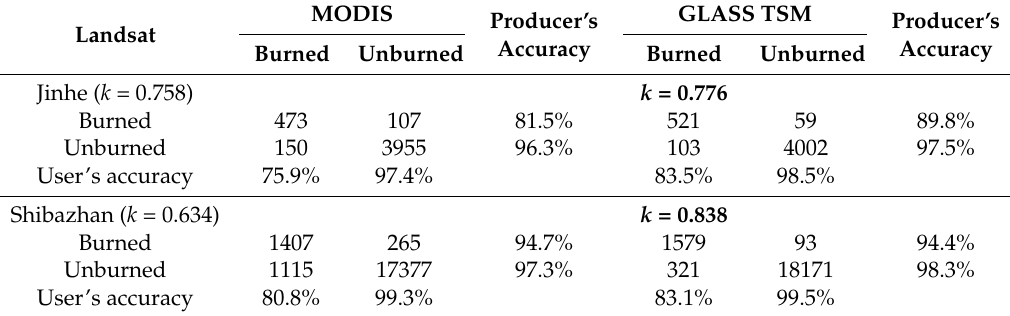
Table 2. Regional confusion matrices and kappa coefficient ( k ) from geographic accuracy assessment. MODIS = Moderate Resolution Imaging Spectroradiometer; TSM = time-stepping